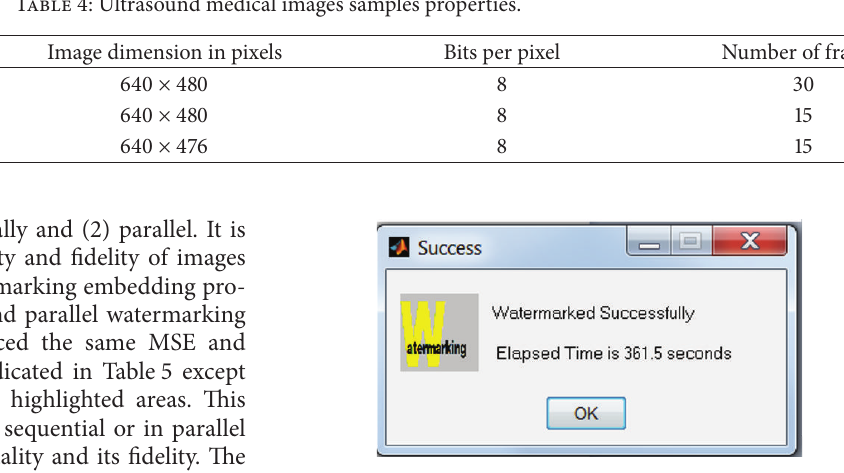
Figure 8: Message displayed upon the completion of sequential watermarking embedding process.